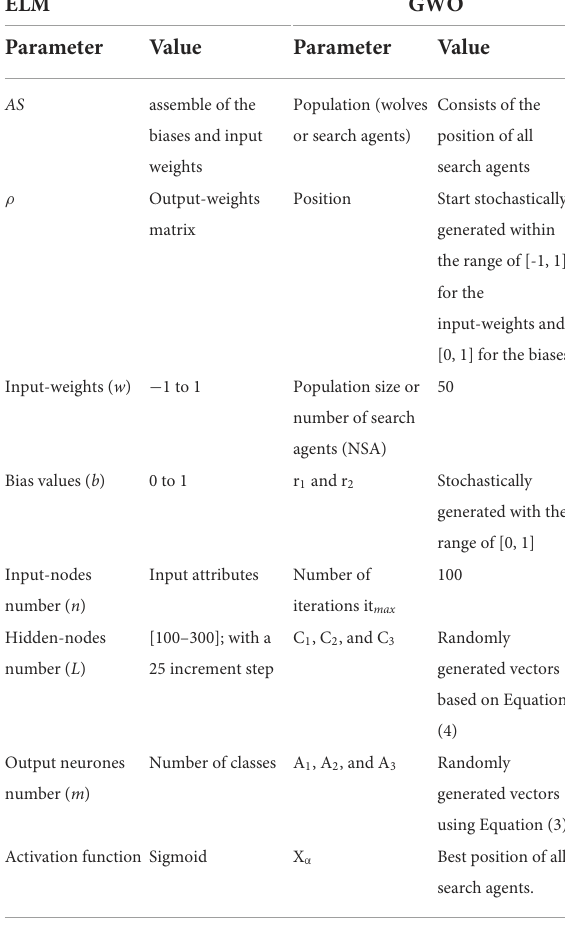
TABLE 5 The parameters settings for the ELM and GWO.